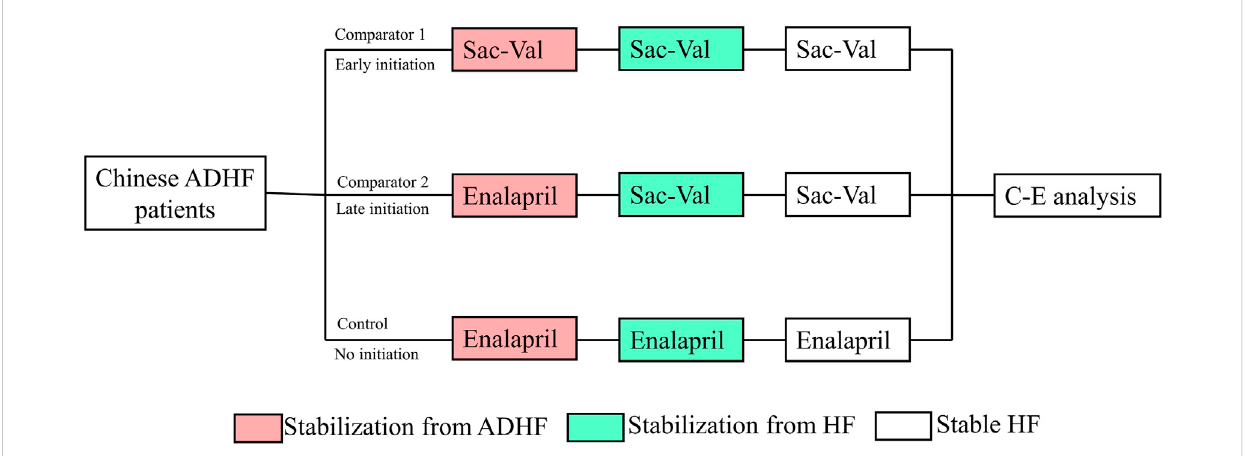
FIGURE 1 Abbreviation: ADHF, acute decompensated heart failure; Sac – val, sacubitril – valsartan; C-E. cost-effectiveness; HF, heart failure. Chinese ADHF patients were randomly allocated to receive early initiation of sacubitril – valsartan, late initiation of sacubitril – valsartan, or no initiation. After a lifetime simulation, the cost-effectiveness analysis was performed.